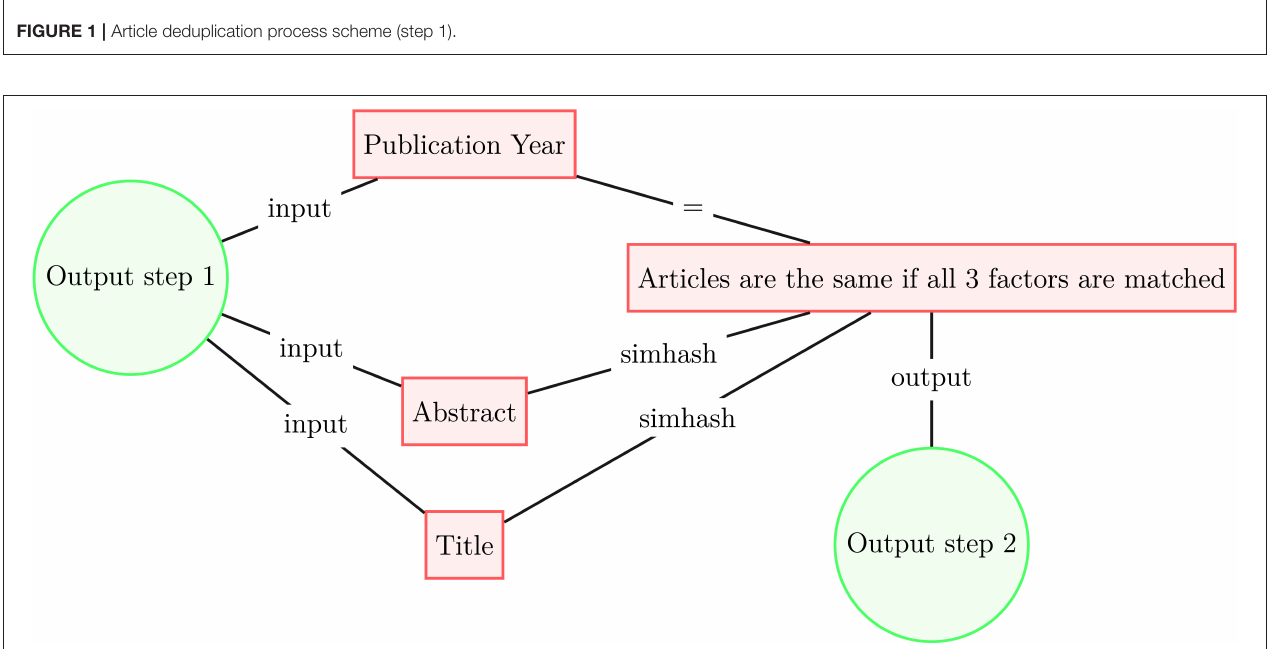
FIGURE 2 | Article deduplication process scheme (step